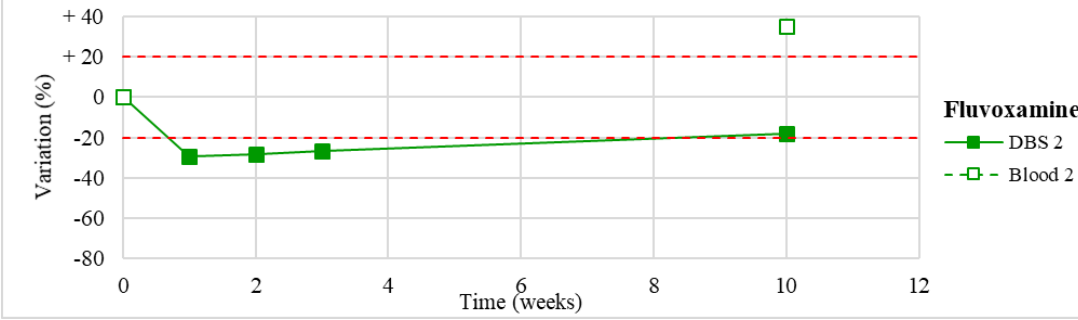
Figure 10. Long-term stability of fluvoxamine ( n = 1) in DBSs stored at room temperature and in blood stored at −20 °C (T0–T4).